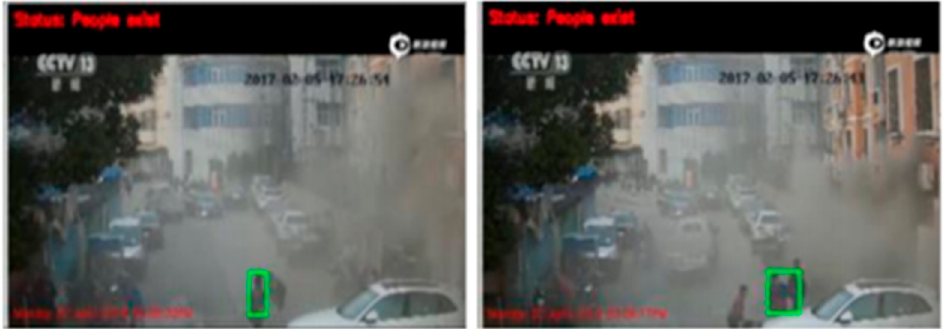
Figure 1. Two examples of human detection in smoke scenes, indicated with green boxes.